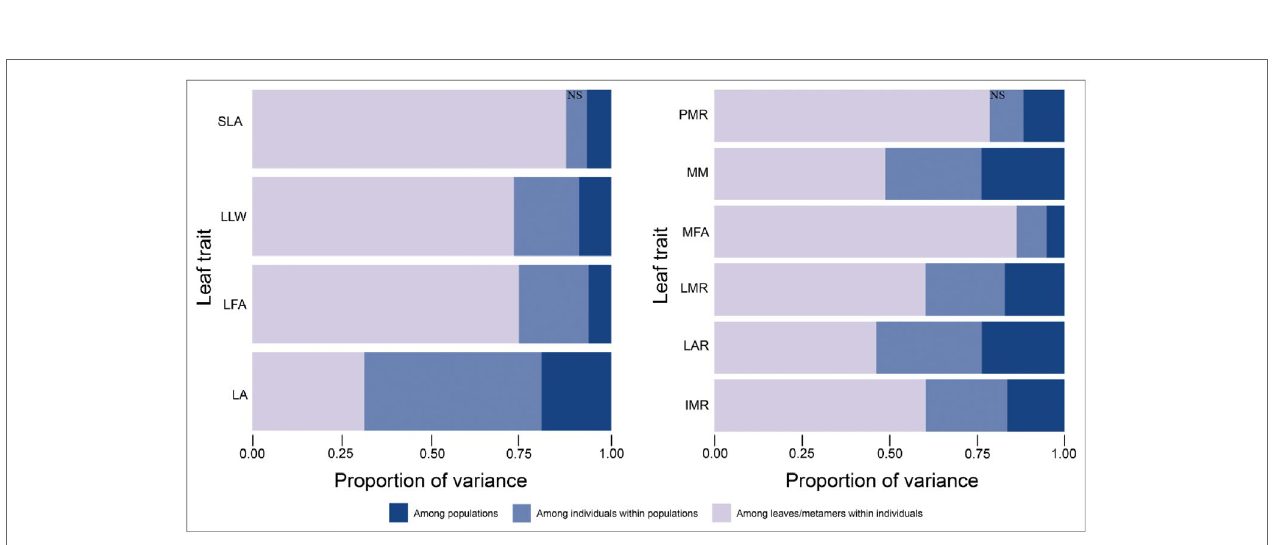
FiGUrE 3 | Hierarchical partitioning of variance for metamer traits in Qualea grandiflora . Variance components and significance levels were determined by randomization (see Methods). All variance components were significant, except SLA and PMR among individuals (NS).